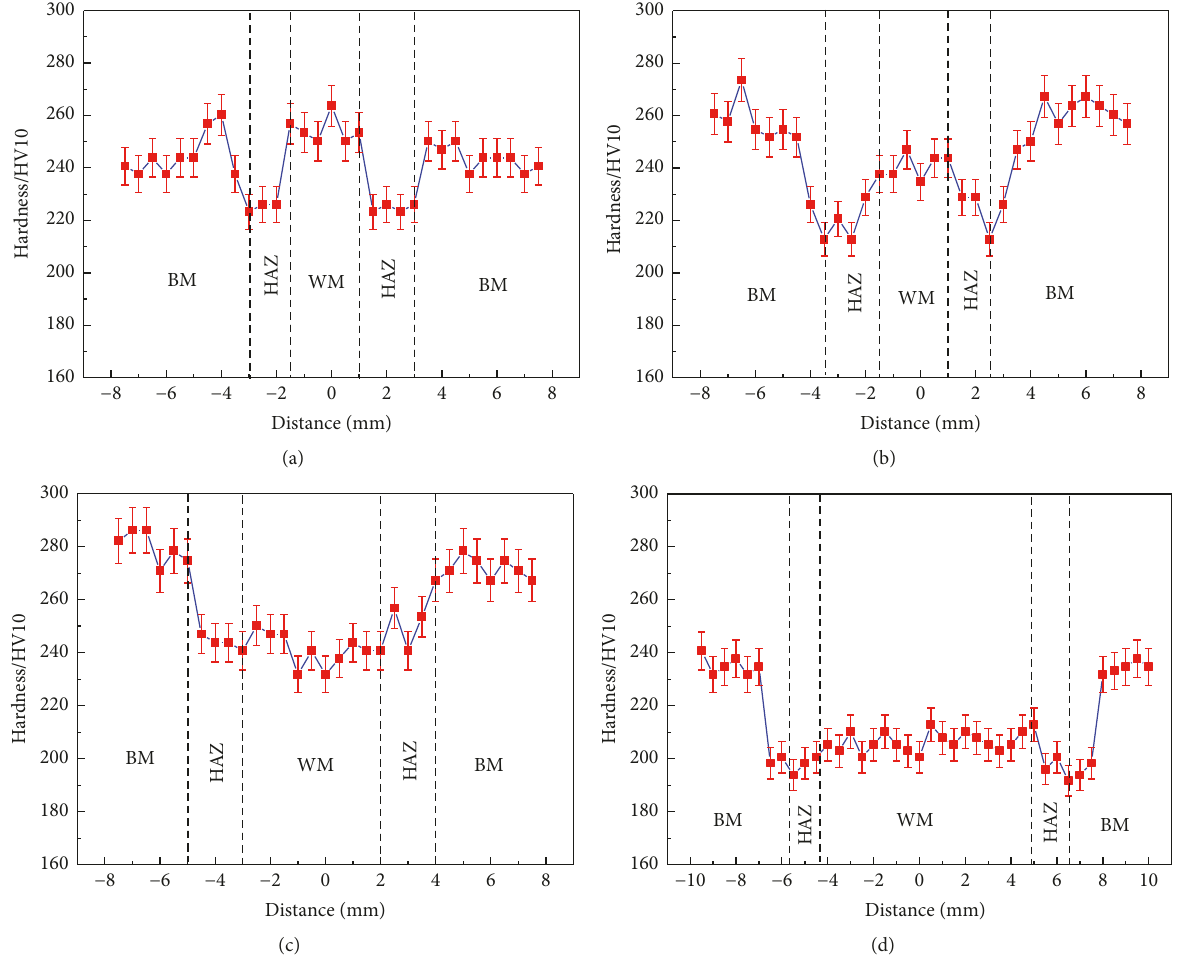
Figure 6: Macro hardness of welded joint within (a) root pass, (b) hot pass, (c) filling layer, and (d) cap layer.